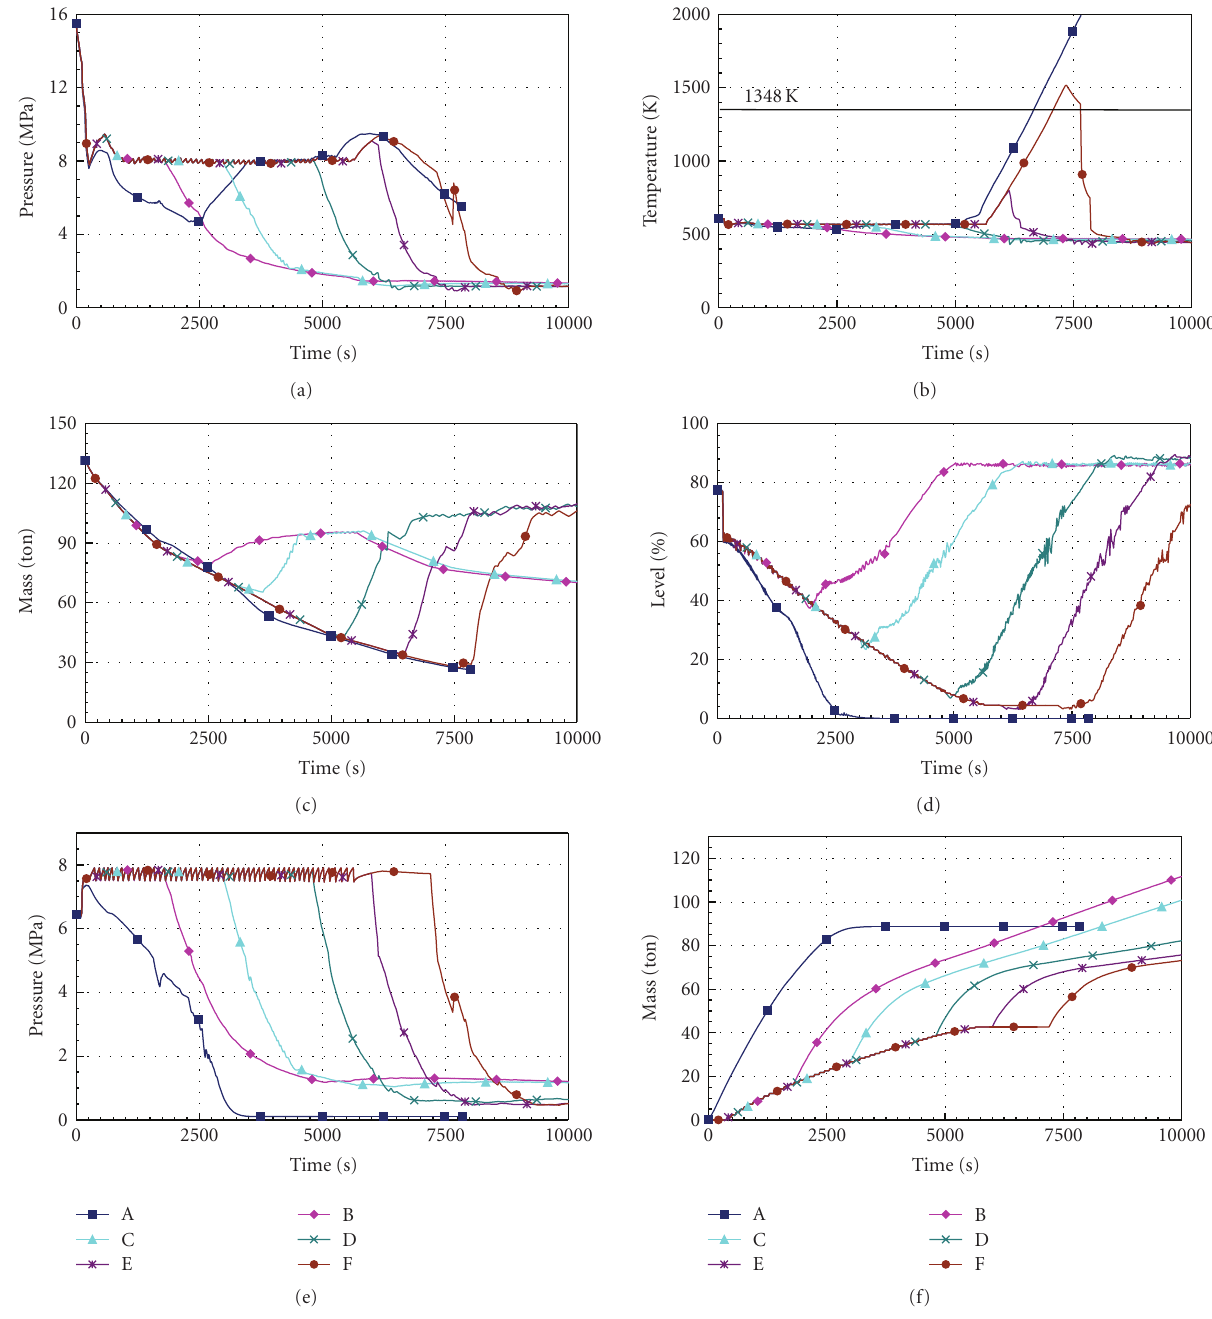
Figure 4: 2.54 cm break scenarios with two operator actions: (a) RCS pressure, (b) core cladding temperature, (c) RCS mass inventory, (d) SG no. 1 wide range level, (e) SG no. 1 pressure, (f) mass discharged through SG no. 1